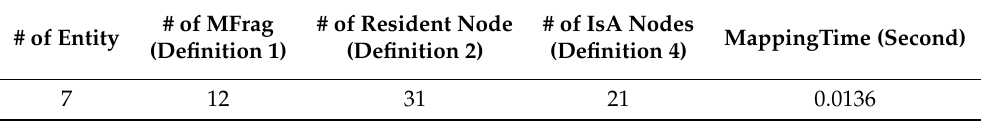
Table 6. The Results of the MEBN-RM Mapping for the Partial HERALD Relational Database (Figure 4) and Its Mapping